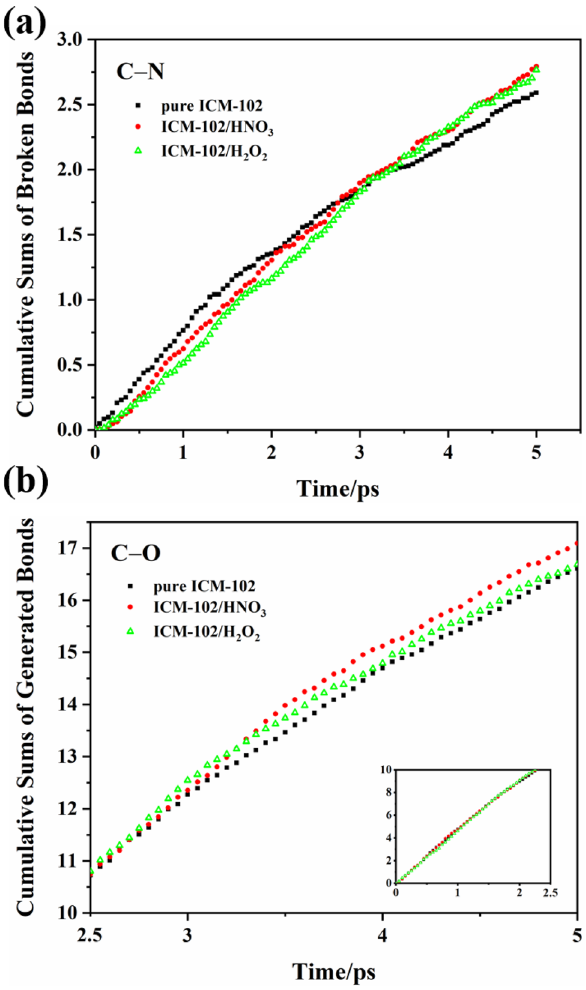
Figure 6. Changes of the cumulative sums of net generated/broken bonds with time in the pure ICM-102, ICM-102/H 2 O 2 , and ICM-102/HNO 3 systems at 3000